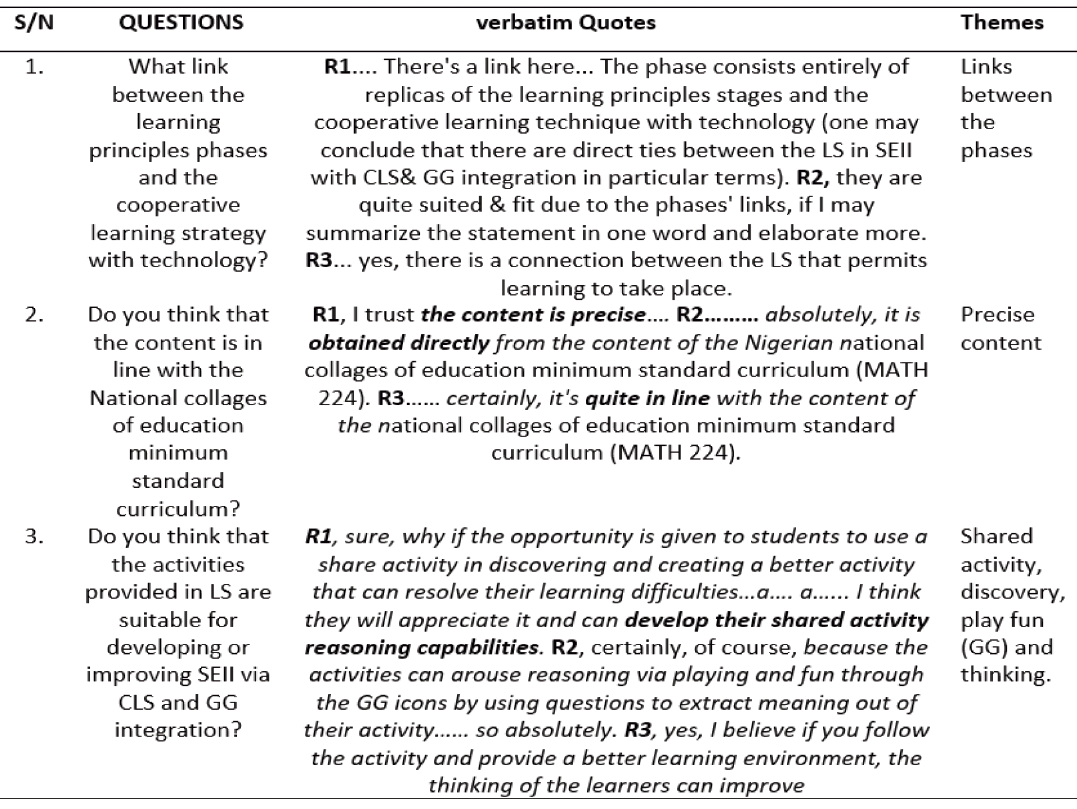
Table 3. Responses from the Experience lecturers’ interview about LS in SEII with CLS and